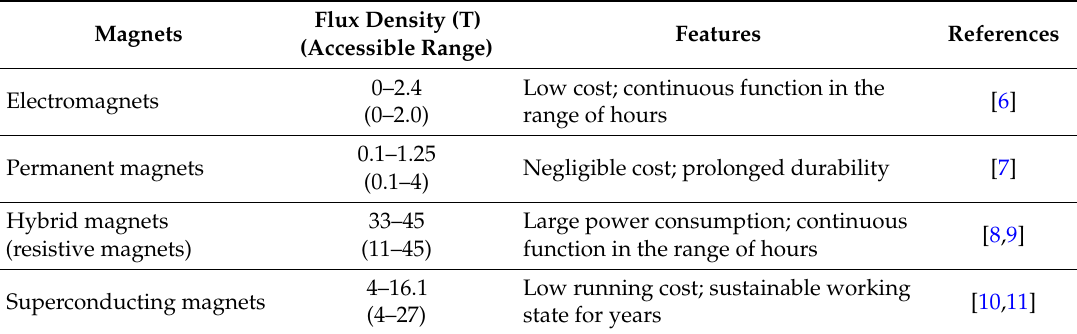
Table 1. Different magnets used for protein